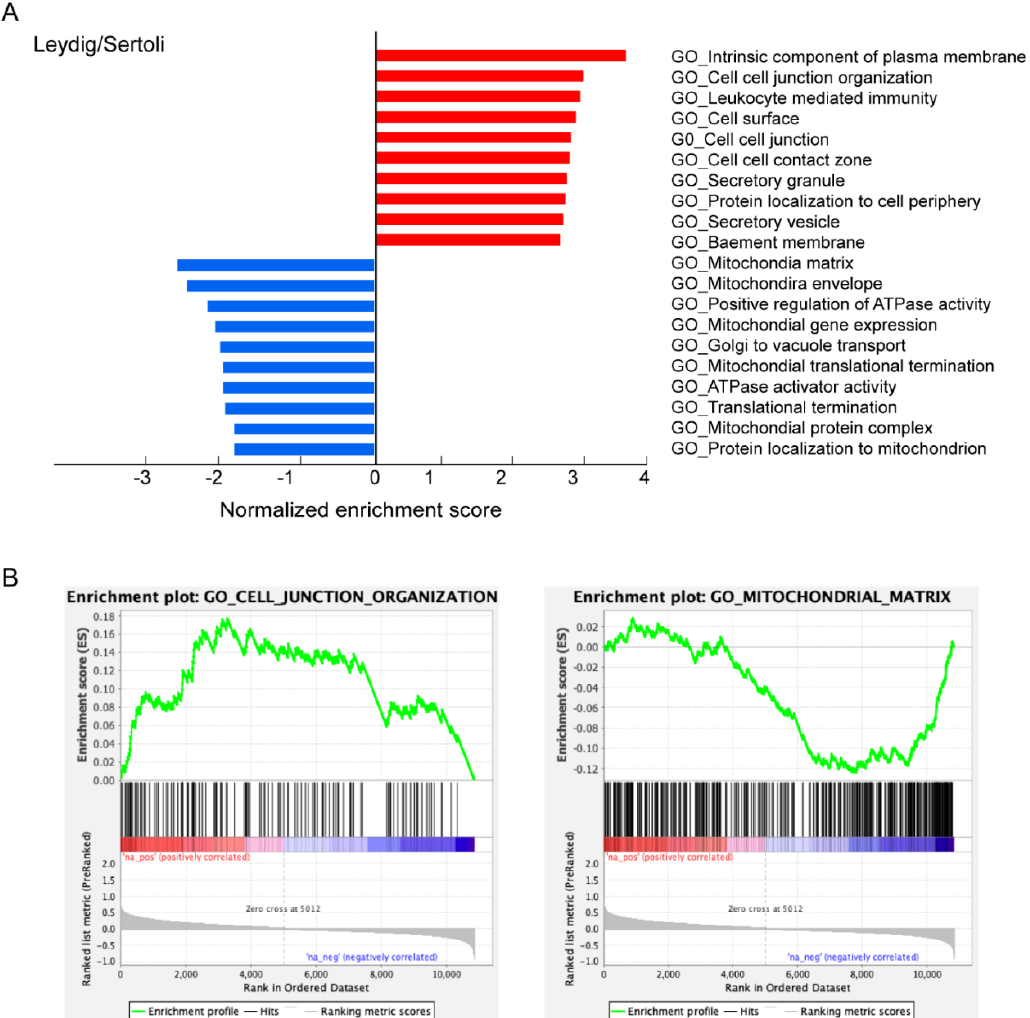
Figure 5. Characteristics of ACE2-positive Leydig and Sertoli cells. ( A ) Gene ontology enrichment analysis of biological process categories of ACE2-positive Leydig and Sertoli cells compared with ACE2-negative cells. ( B ) Examples of the enrichment plot for terms of cell–cell junction organization and mitochondrial matrix.